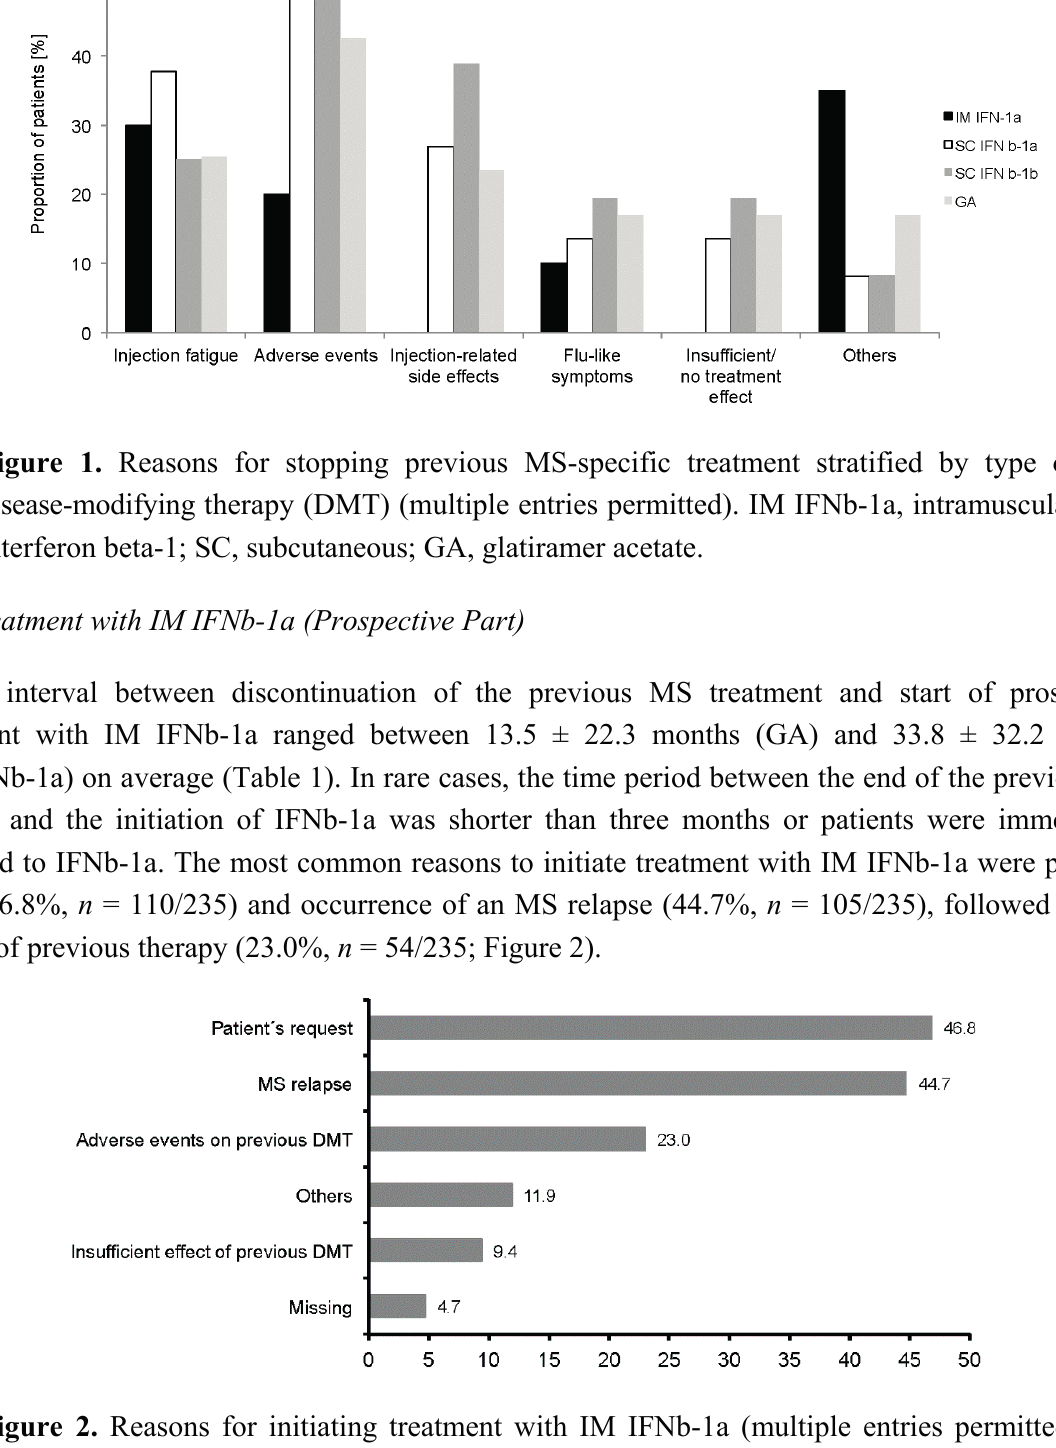
Figure 2. Reasons for initiating treatment with IM IFNb-1a (multiple entries permitted, n = 235). Patient’s wish: n = 110/235; MS relapse: n = 105/235; adverse events